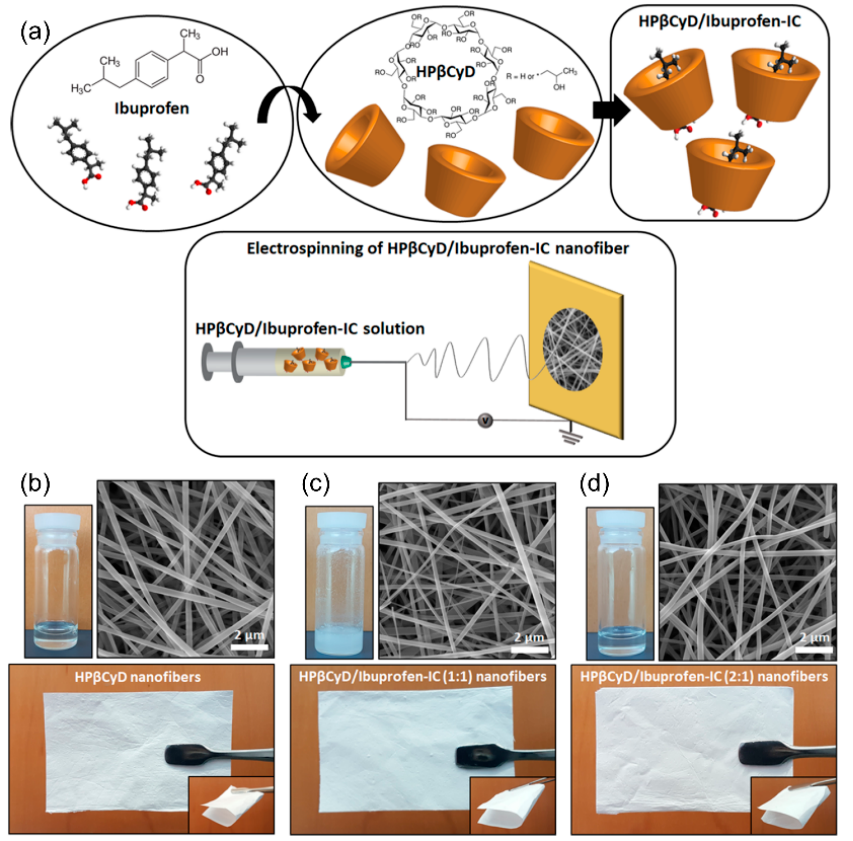
Figure 18. ( a ) Schematic of the inclusion complex formation between ibuprofen and HP β CyD molecules and electrospinning of HP β CyD/ibuprofen-IC NFs. Photographs of electrospinning solutions and the resulting electrospun nanofibrous webs and representative SEM images: ( b ) pure HP β CyD NFs, ( c ) HP β CyD/ibuprofen-IC NFs (1:1), and ( d ) HP β CyD/ibuprofen-IC (2:1) NFs. Reproduced with permission from [112], Copyright © 2021, American Chemical Society.